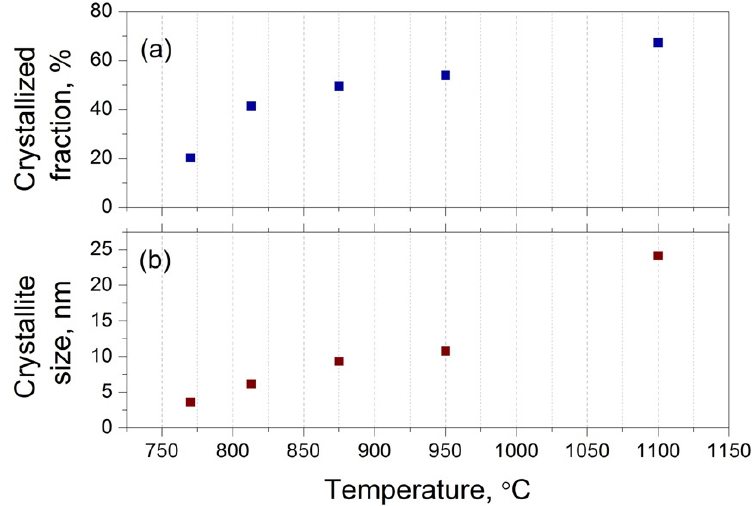
Figure 3. ( a ) Crystallized fraction and ( b ) crystallite size of the gahnite determined from the XRD studies for the glass samples heat treated up to 1100 °C for 20 h for the Matrix series.